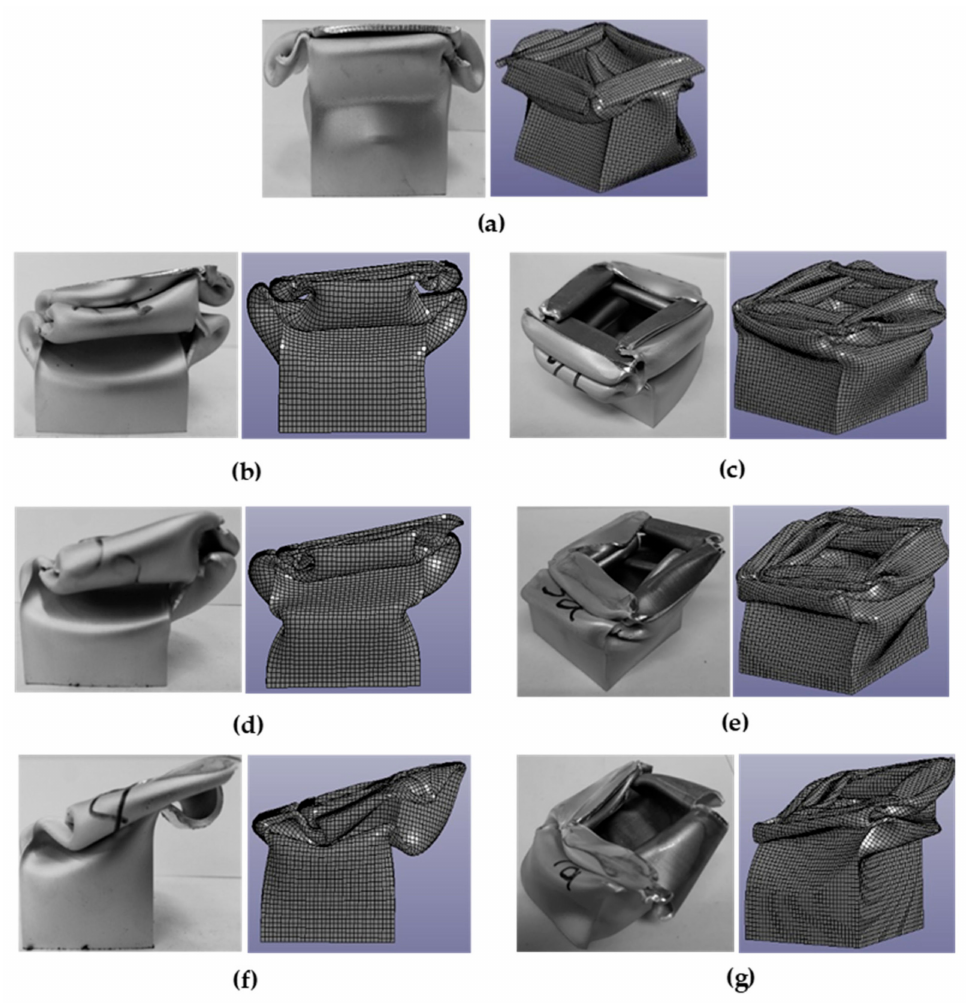
Figure 17. Final views of fully crushed tubes. ( a ) axial; ( b ) 5 ◦ —edge; ( c ) 5 ◦ —corner; ( d ) 10 ◦ —edge; ( e ) 10 ◦ —corner; ( f ) 15 ◦ —edge; ( g ) 15 ◦